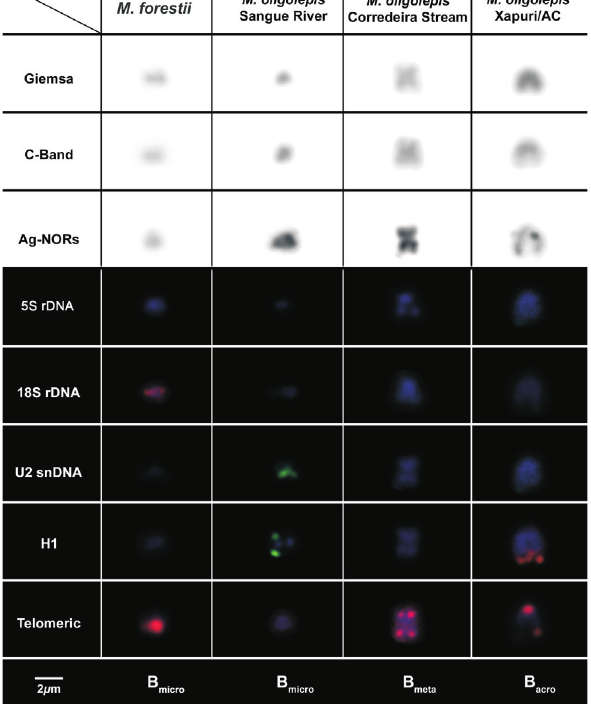
Figure 8 - The B chromosomes of the Moenkhausia species analyzed in